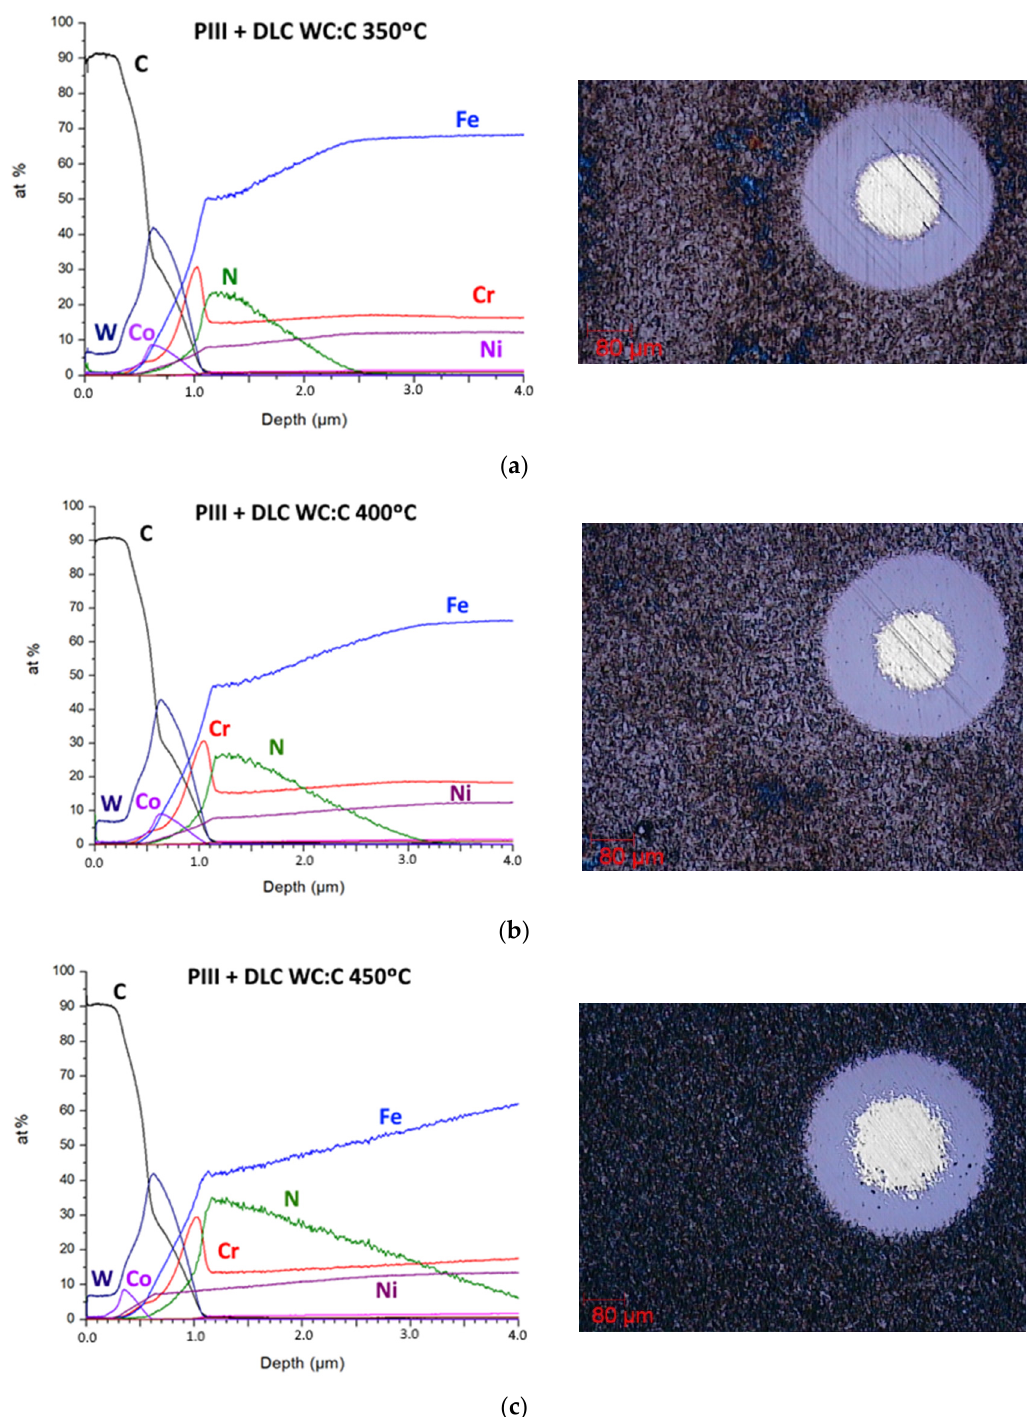
Figure 12. Glow discharge optical emission spectrometry (GD-OES) concentration profiles and calotests for ( a ) PIII + DLC WC:C 350 °C, ( b ) PIII + DLC WC:C 400 °C and ( c ) PIII + DLC WC:C 450 °C.